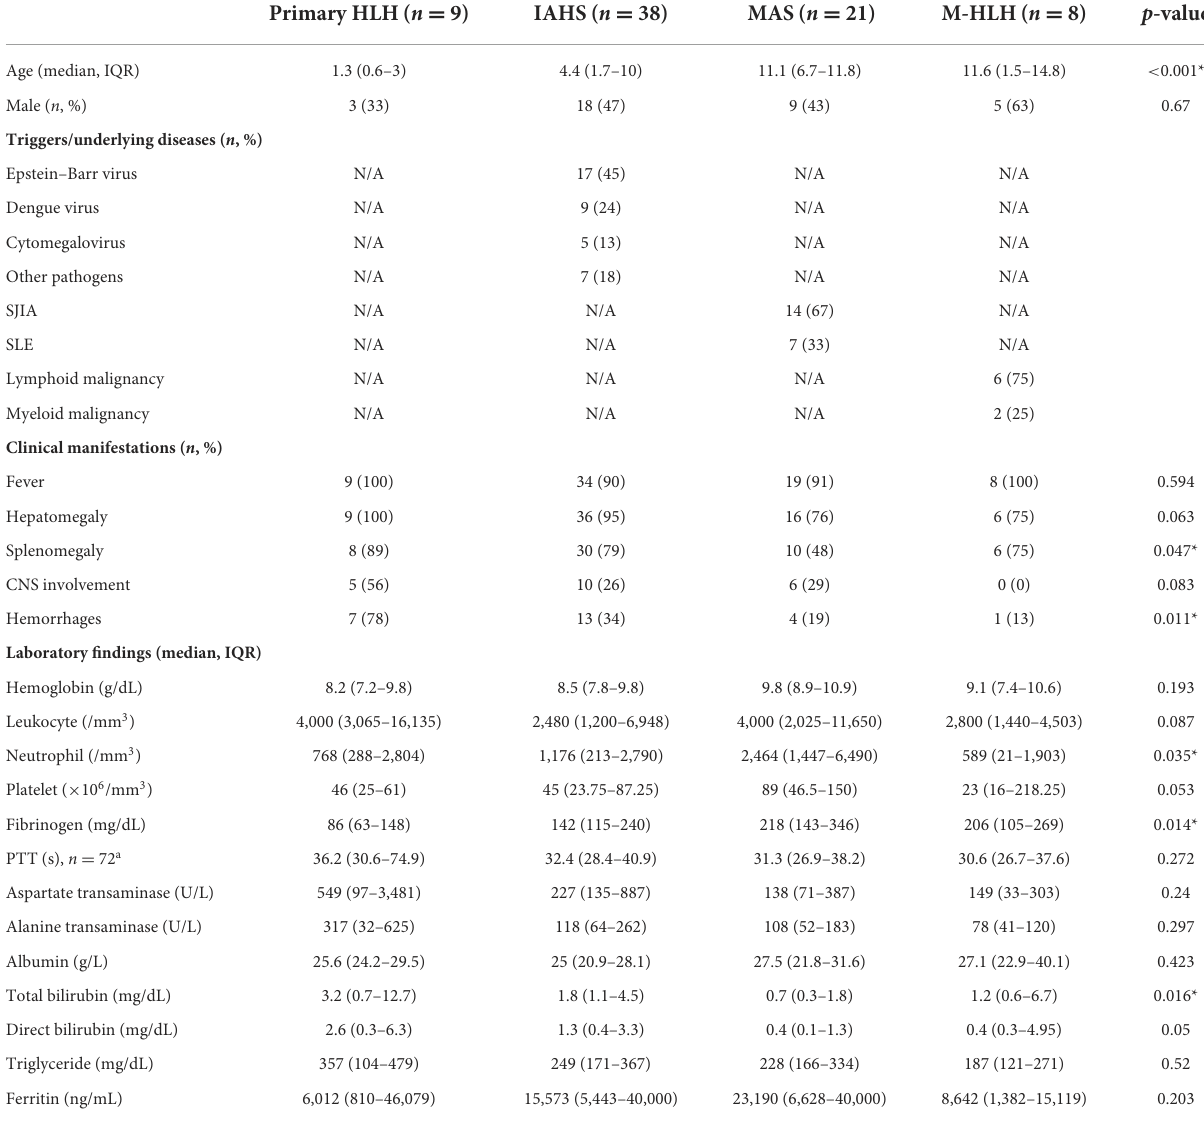
TABLE 1 Baseline clinical features and laboratory findings in HLH patients with different